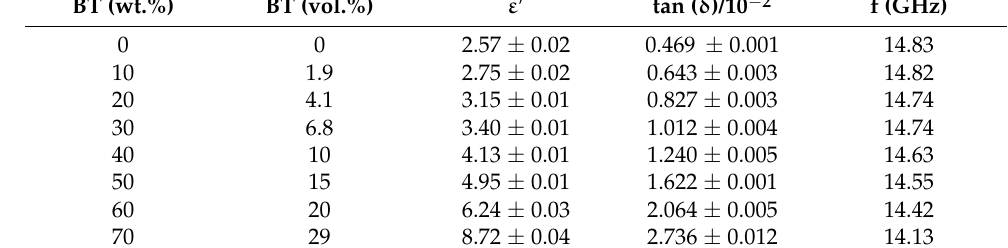
Table 1. Dielectric properties of 3D-printed polymer composite with various loadings of BT in ABS (available under Creative Commons license [58]).